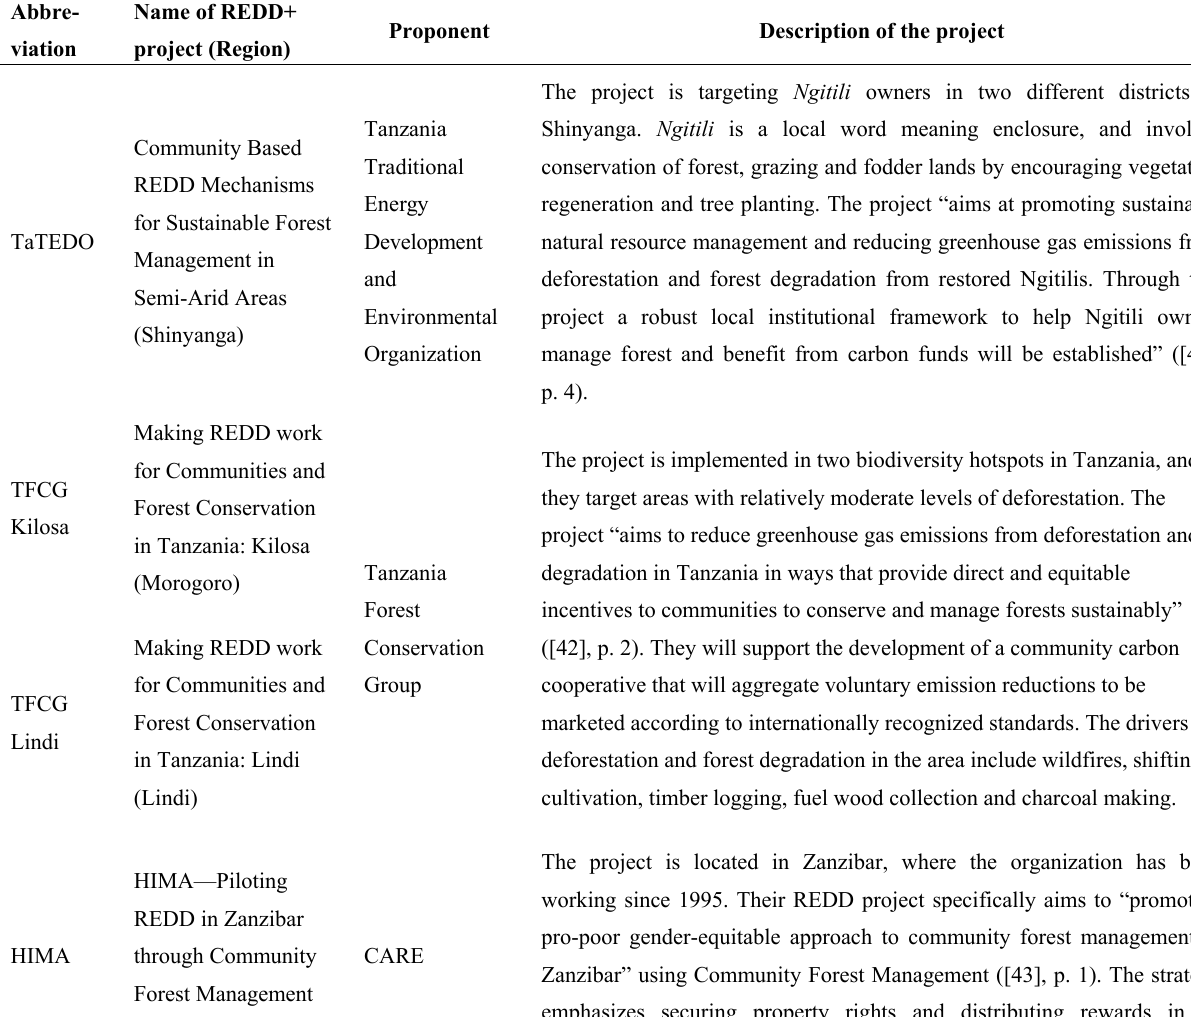
Table 1. Overview of REDD+ Pilot Project Sites Included in the